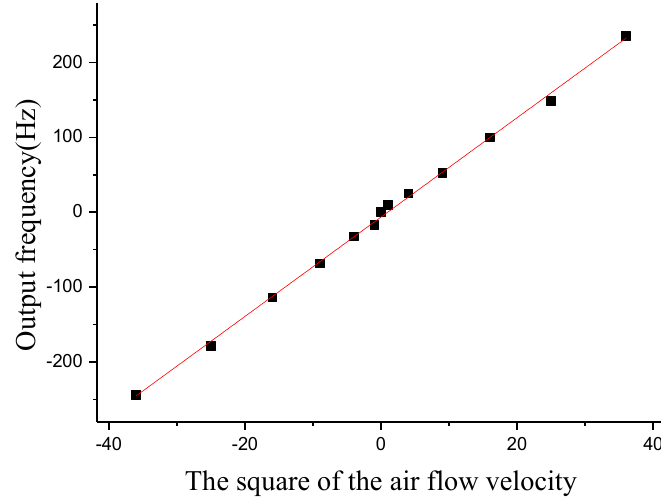
Figure 17. The output signal fitting curve of the superficial artificial lateral line system.